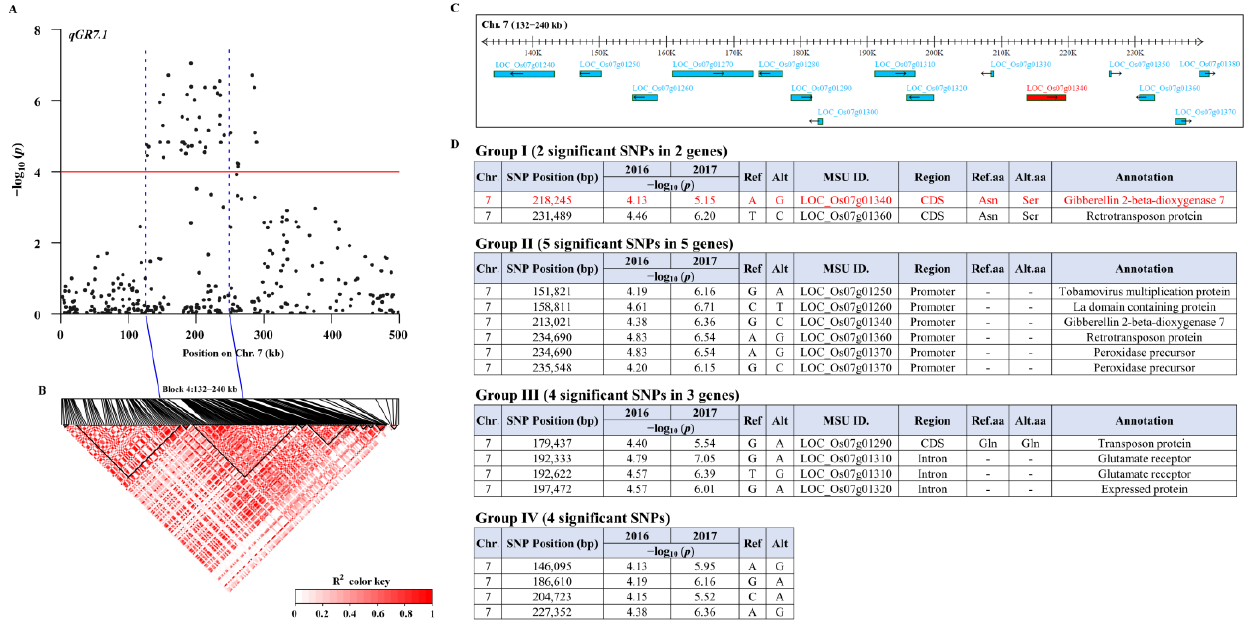
Figure 3. Identification of candidate gene for qGR7.1 . ( A ) Regional Manhattan plot surrounding the peak on chromosome 7 (0 – 500 kb); ( B ) LD heatmap for qGR7.1 ; ( C ) Fifteen annotated genes within the LD block (132 – 240 kb) of qGR7.1 ; ( D ) Fifteen common significant SNPs across two years within the LD block of qGR7.1 were divided into four functional groups. As a measure of LD, the color intensity of the box on the LD plot corresponds with the extent of R 2 according to the legend. From an LD analysis, 11 blocks (inverted black triangles) were identified on qGR7.1 . The lead SNP was located within an approximately 108-kb block (Block 4: 132,222 to 240,062 bp). The rectangles show the position of 15 annotated genes within the LD block (132 – 240 kb) of qGR7.1 . The black arrow direction represents the orientation of transcription. The red rectangle indicates the causal gene (LOC_Os07g01340; OsGA2ox5 ) of qGR7.1 . The non-synonymous SNP (Chr7-218,245) shown in red was located in the coding region of OsGA2ox5 .